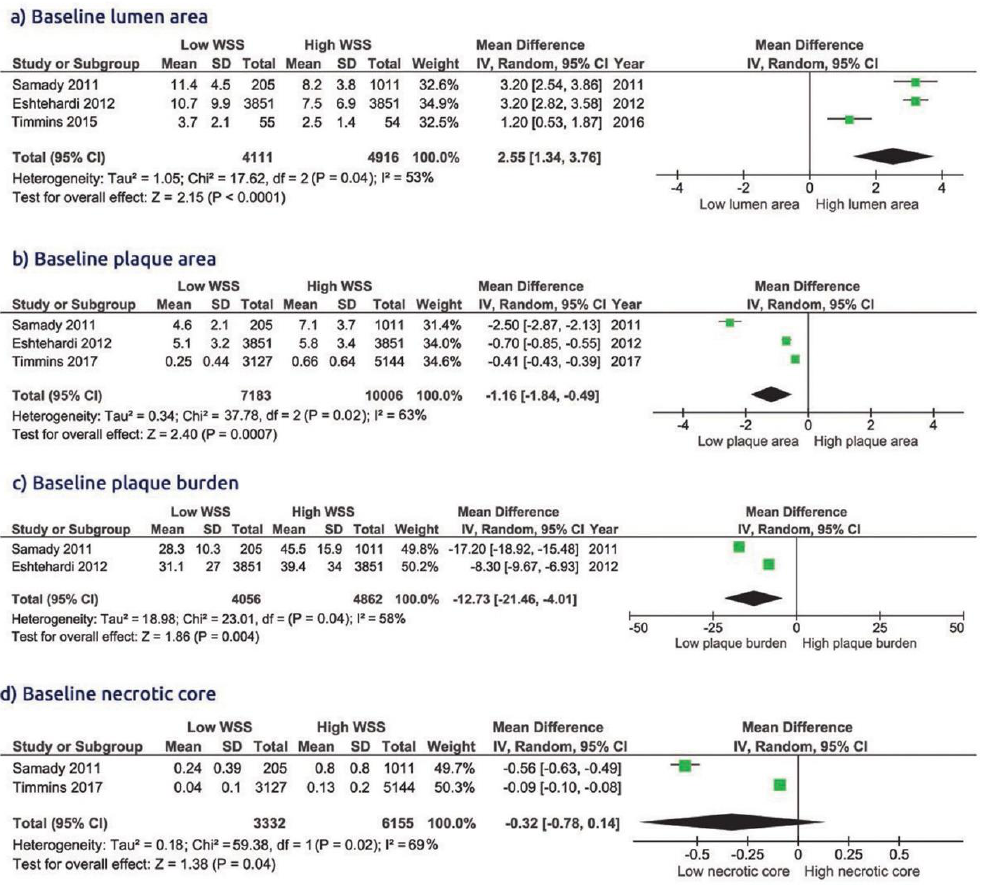
Figure 2. Comparison of baseline lumen area, plaque area, plaque burden, and necrotic core in group of low WSS vs. high WSS.